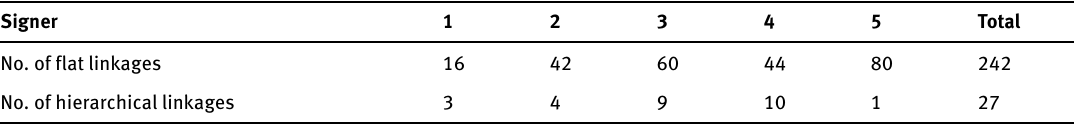
Table 6. Frequencies of flat and hierarchical linkages in the data. Signer 1